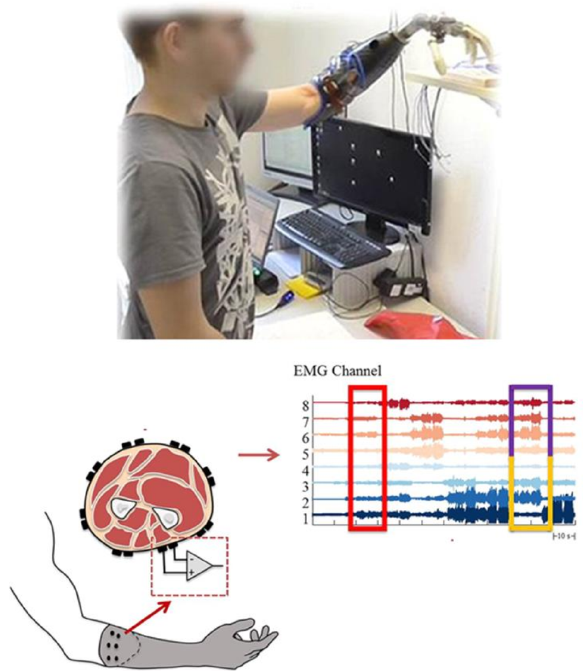
Figure 2. Active myoelectrically controlled hand prosthesis, generation of signals, and signals in the electromyography (EMG)